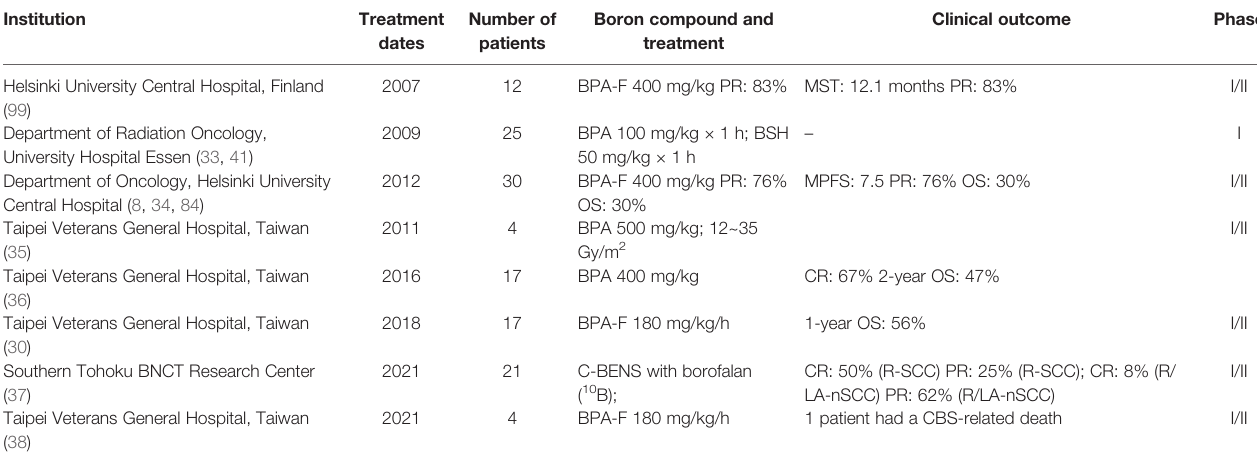
TABLE 5 | Clinical studies of BNCT application in head and neck